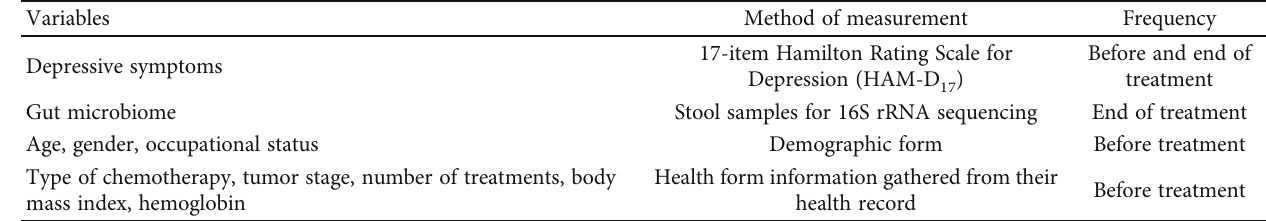
Table 1: Summary of